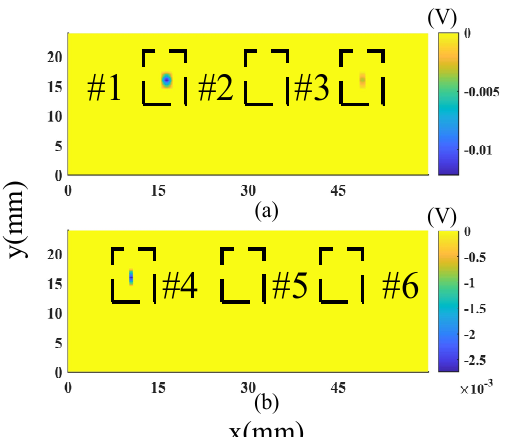
Figure 16. Horizontal channel images of the reference probe: ( a ) defects #1 − #3 and ( b ) defects Figure 15. ( a , b ) are the SD mode fused images of defects #1 − #3 and defects #4 − #6, respectively. #4 − #6.